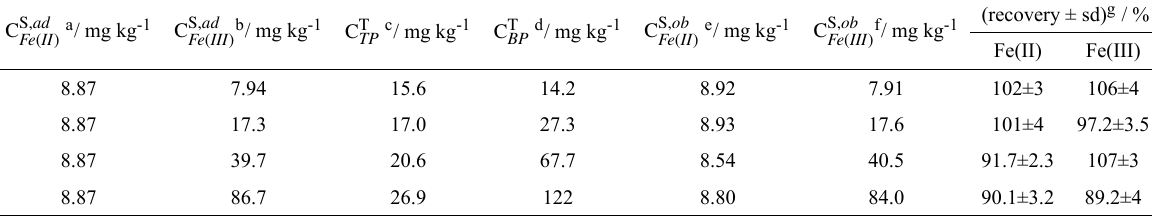
Determination of Fe(II) and Fe(III) concentration in water